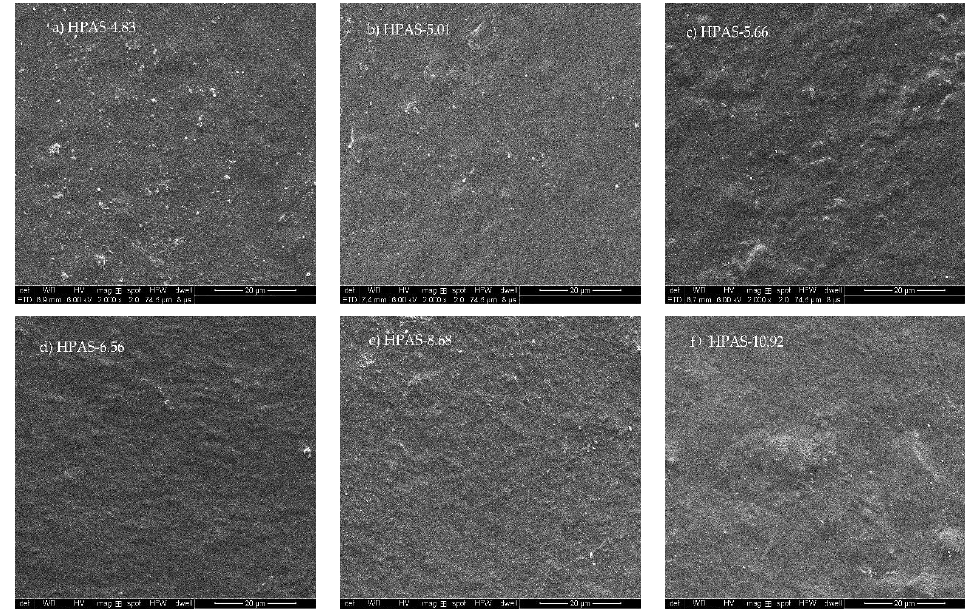
Figure 4. SEM images of HPAS-CA films with different citric acid amount at 2000×